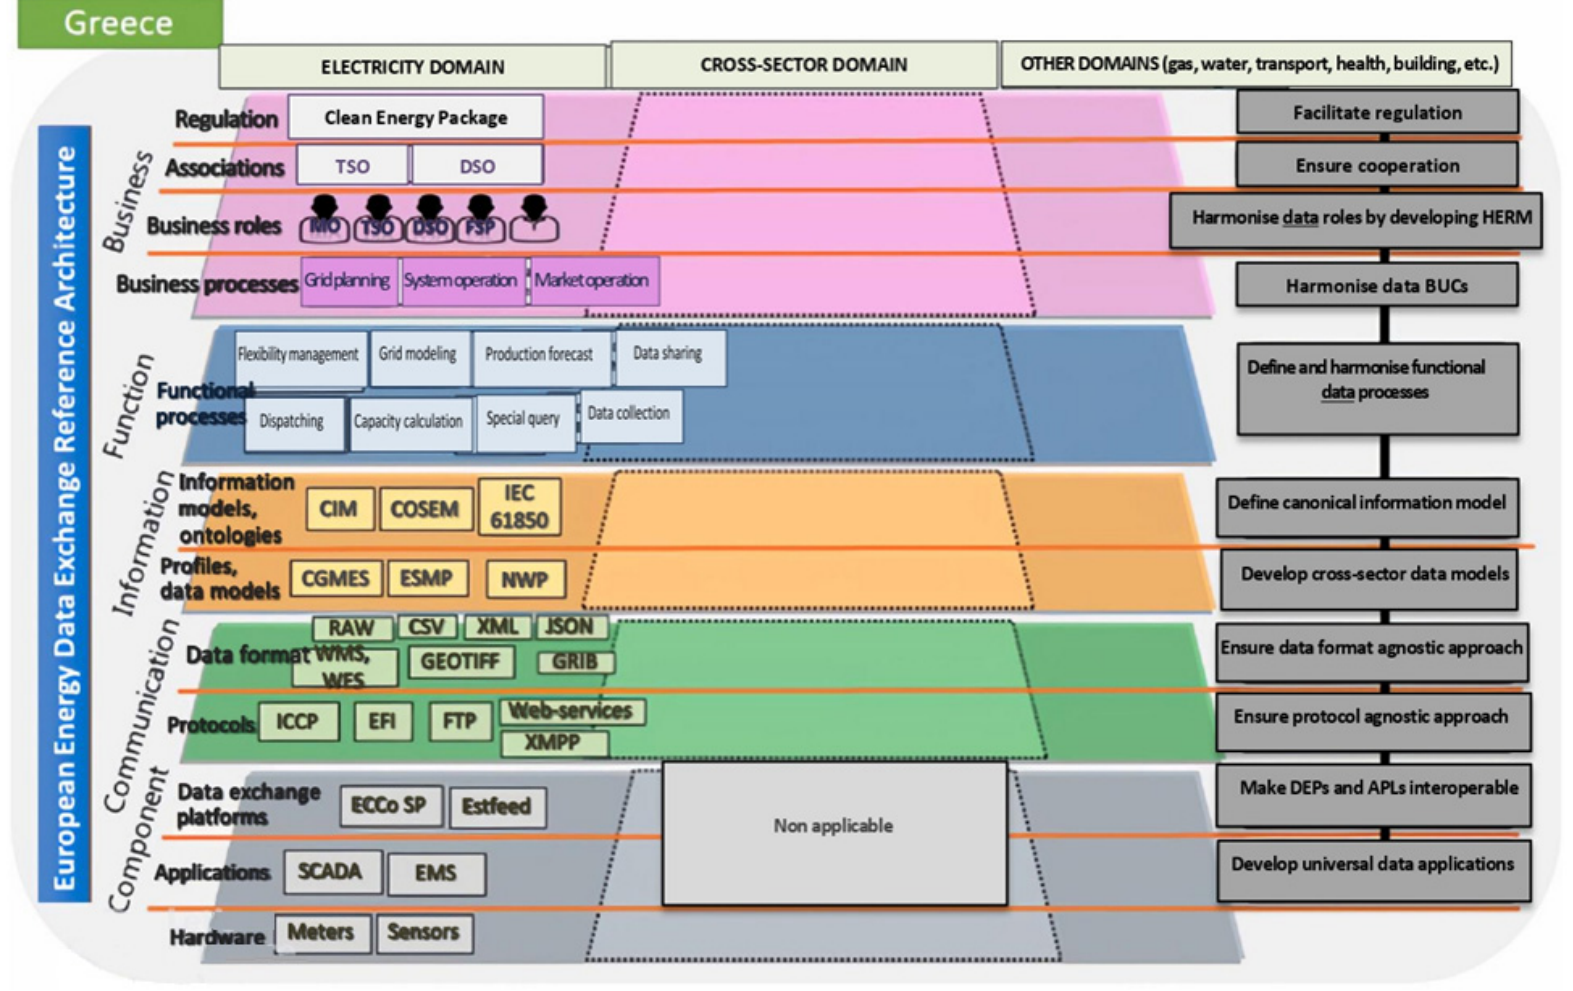
Figure 10. Identified domains for integration with F-channel.